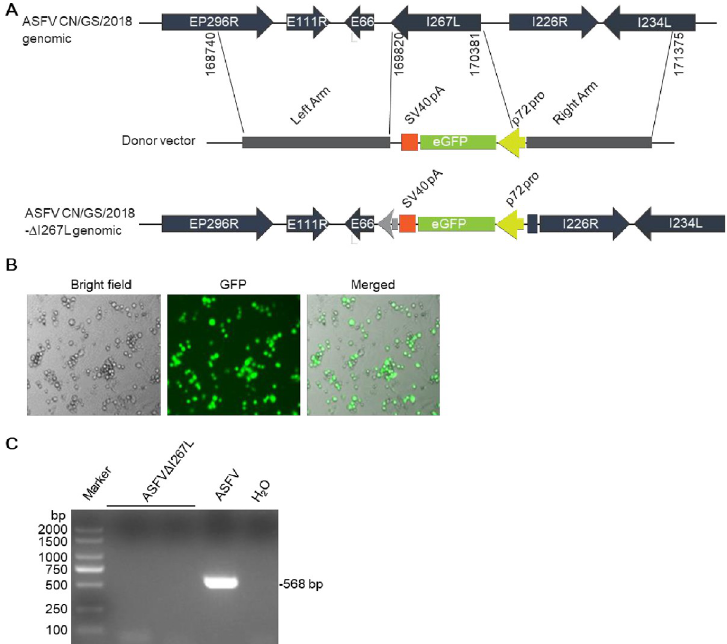
Fig 5. Generation of I267L-deficient virus. ( A ) Schematic presentation of generation of I267L-deletion virus by homologous recombination. ( B ) Confirmation of the successfully recombination by fluorescence microscopy. ( C ) Absence of parental ASFV CN/GS/2018 in ASFV Δ I267L virus stock was confirmed by PCR.